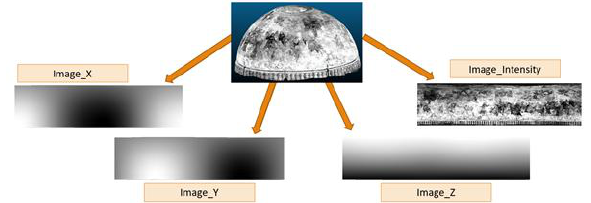
Figure 3 : Diagram presenting the generation of spherical images from the TLS point cloud.